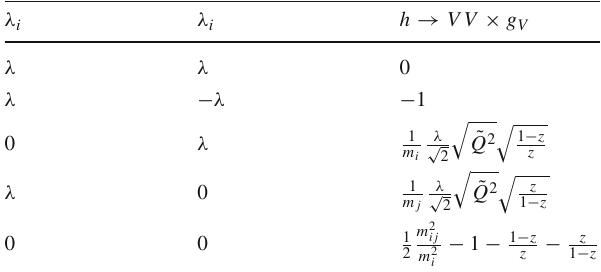
Table 7 Branching amplitudes for Higgs splitting to vector